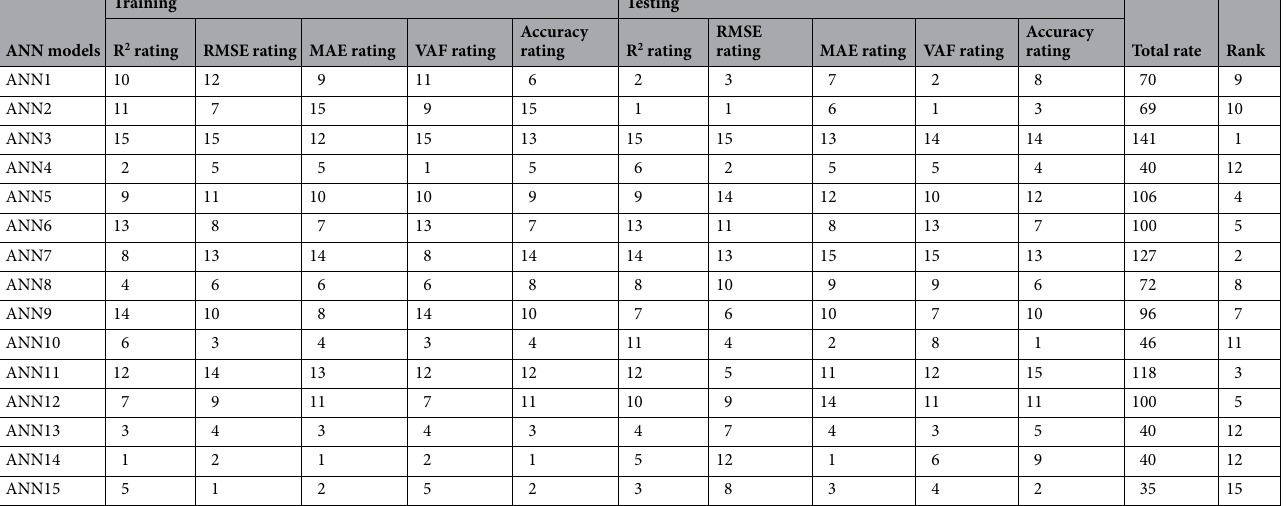
Table 5. Performance of the base models of ANN and their rankings.